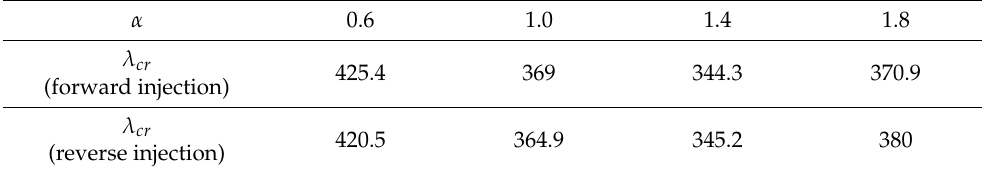
Table 1. The critical dynamic pressure of the panel without in-plane load under different injection.